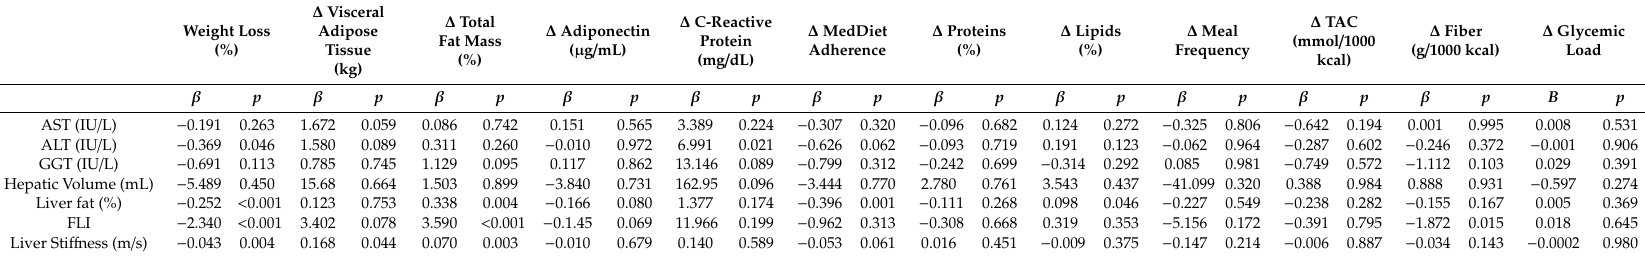
Table 4. Regression analyses of the hepatic status parameters after 6 months of dietary intervention as dependent variables and changes in anthropometric, biochemical, and dietary factors as independent